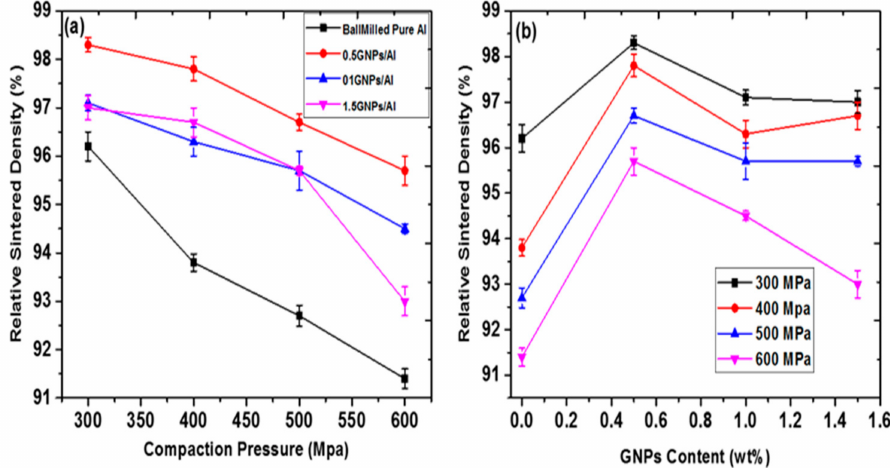
Figure 15. Effect of compaction pressure ( a ) and GNPs content ( b ) on relative sintered density (%) of pure and GNPs/Al nanocomposite.